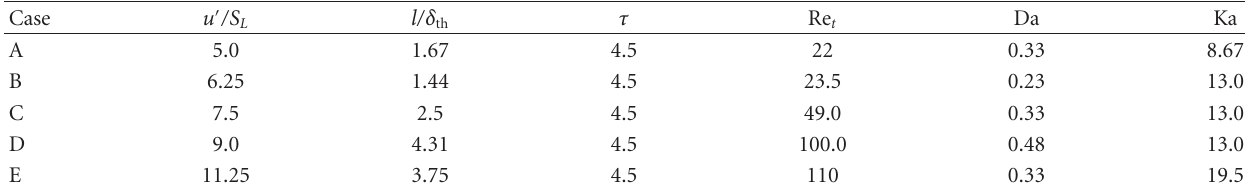
Table 1: Simulation parameters and nondimensional numbers relevant to the DNS